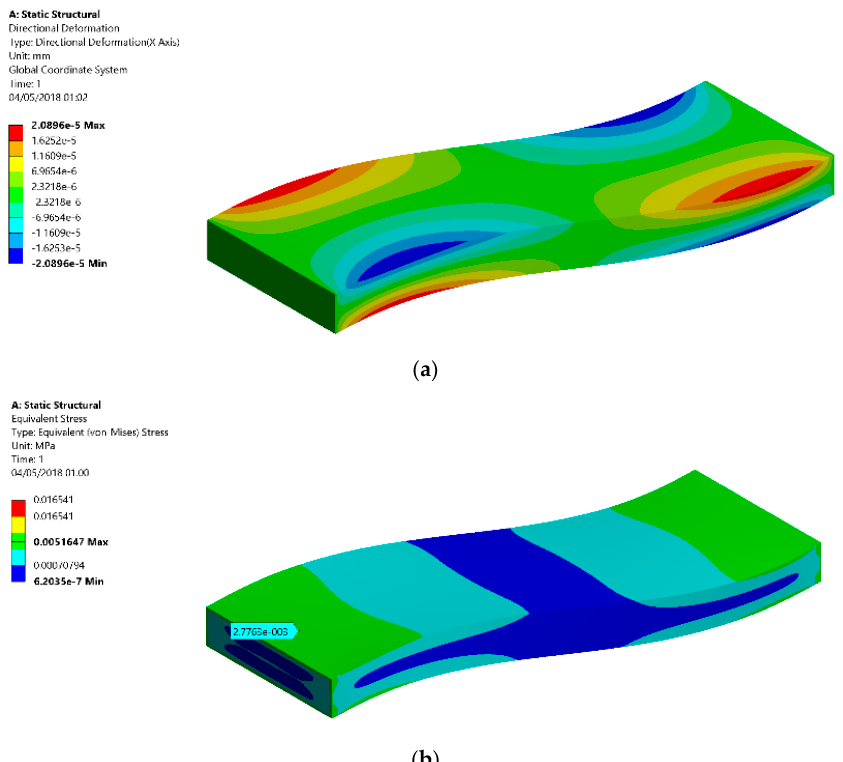
Figure 7. Representation of FEA results in terms of width deformation and stress. ( a ) Deformation; ( b ) Equivalent Stress.